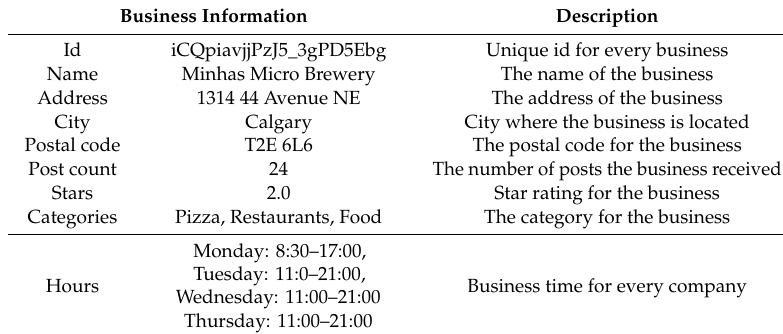
Table 2. An example of business information.